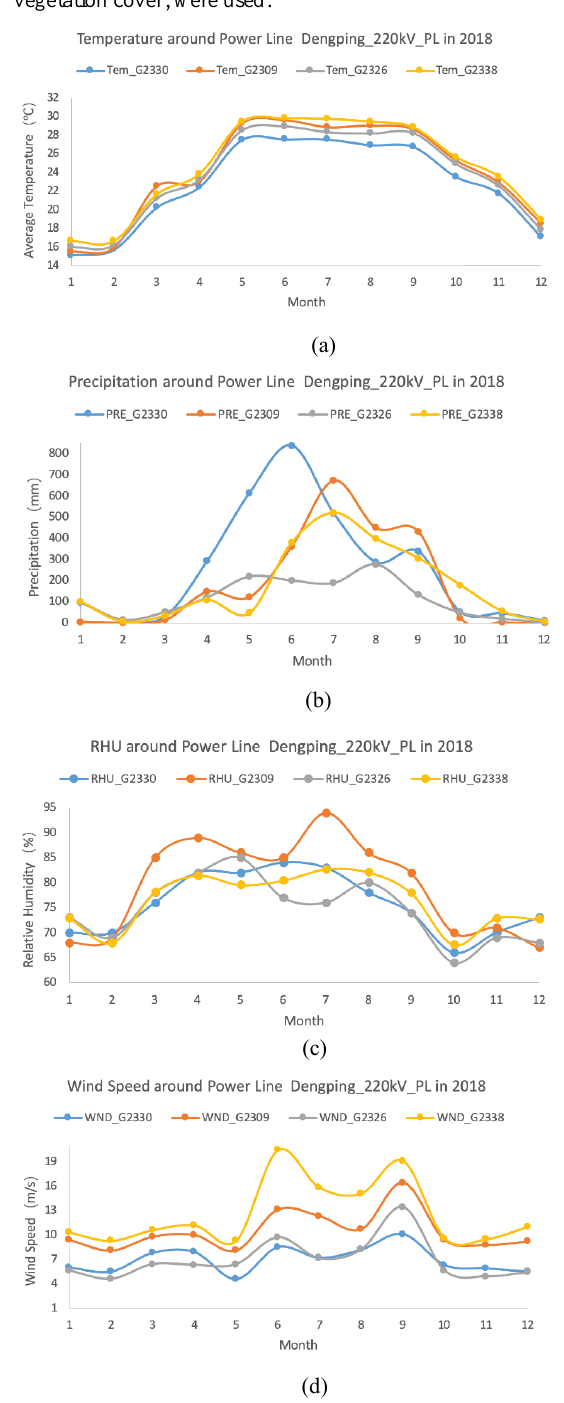
Figure 2 . Meteorological observation around Dengping_220kV HV TL: (a) daily average temperature in each month, (b) daily average precipitation from 20:00 to 20:00 in each month, (c) daily average minimum relative humidity in each month, (d) daily average maximum wind speed in each month.